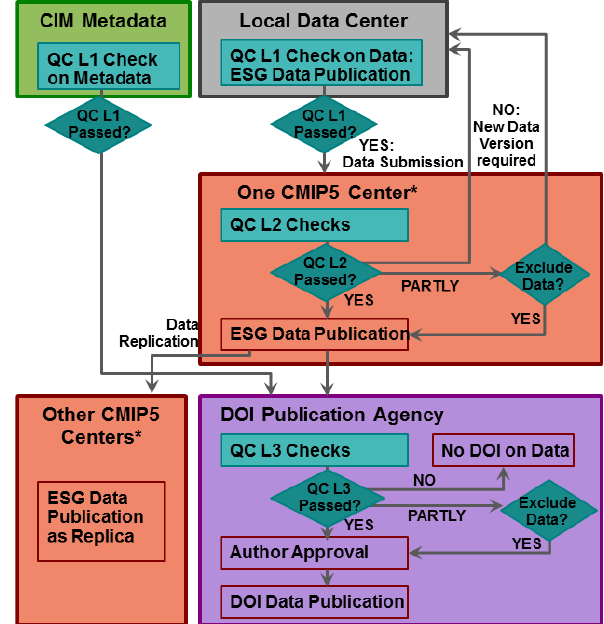
Fig. 3. Workflow of the quality control procedure (*: Current pri- mary CMIP5 data centers are PCMDI, BADC, and